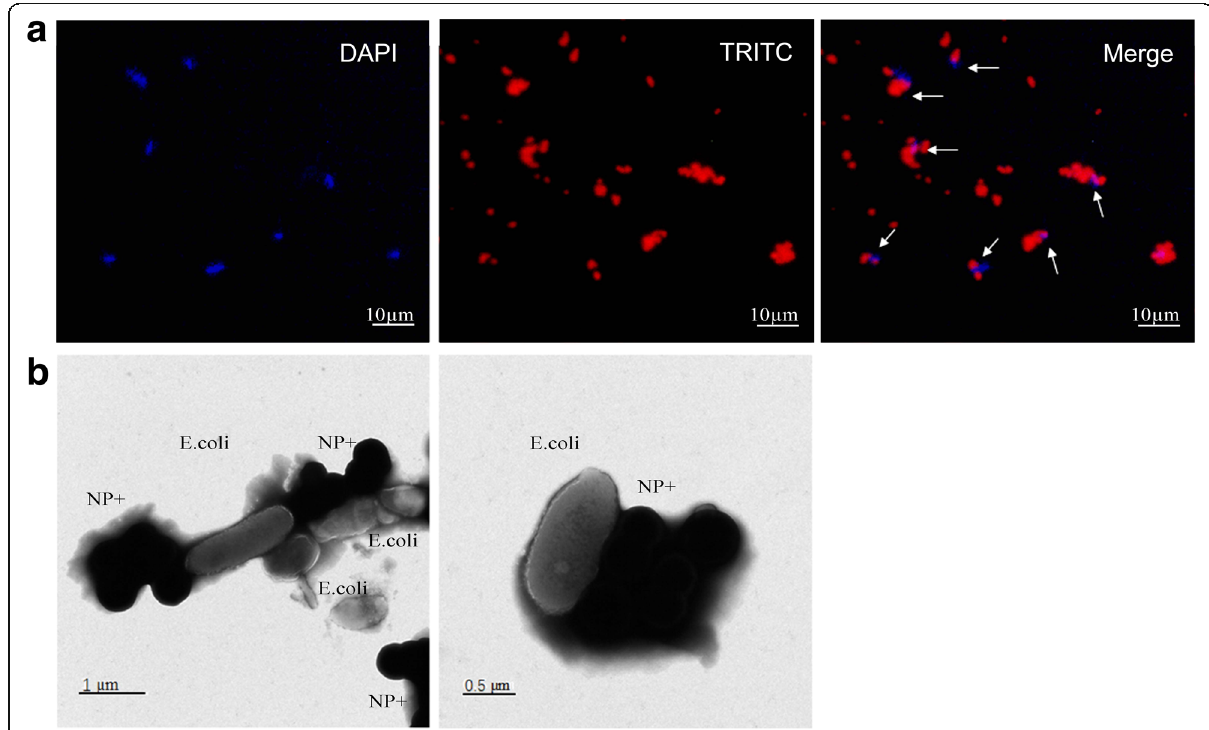
Fig. 5 Fluorescent and TEM images of E. coli binding with NP+. a Upper panels show the fluorescent images of E. coli cells binding with NP+. DAPI is used to stain the cell nucleus. TRITC is labeled in NPs. b Lower panels are representative TEM images showing NP+ and E. coli complexes